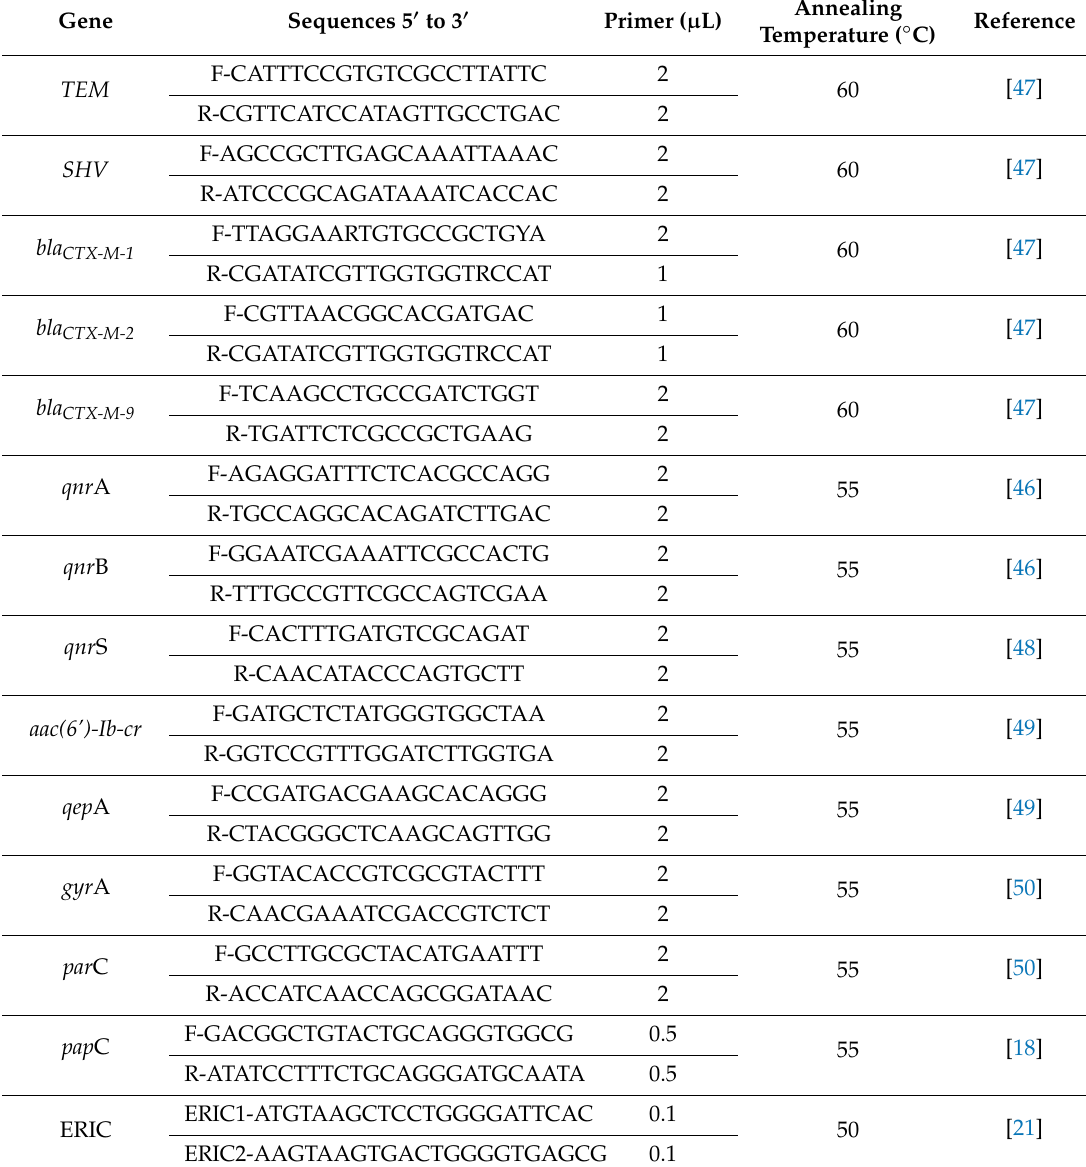
Table A1. Primers, Primer Concentrations and Annealing Temperatures Used for the Molecular Characterization of the E. coli Isolates in this